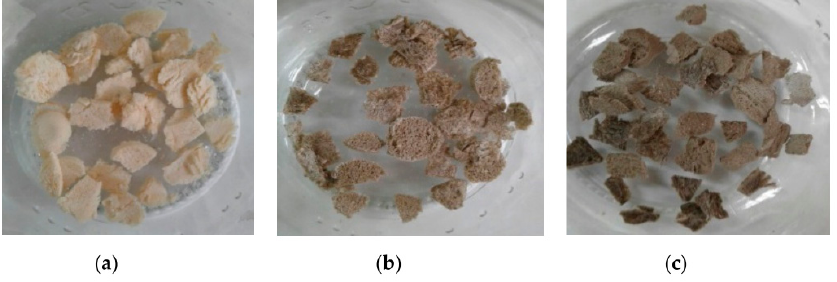
Figure 2. Freeze-dried scaffolds of chitosan (CS) ( a ) without graphene oxide (GO), ( b ) with 0.5% of GO, and ( c ) with 1.0% of GO [43]. Reprint with permission from MDPI. Recently, Mesgar et al. [44] produced gelatin (G)/chitosan (Ch) scaffolds with a reinforcement of functionalized multiwall carbon nanotubes (f-MWCNTs) by freeze-drying. They used a compressive strength test and a scanning electron microscope (SEM) to com- pare porosity, compressive modulus, pore size, and f-MWCNTs dispersion of each frac- tion of nanotubes added to the scaffold sample, delighting the attainment of the strongest reinforced scaffolds at moderate reinforcement levels. In another approach, Chen et al.